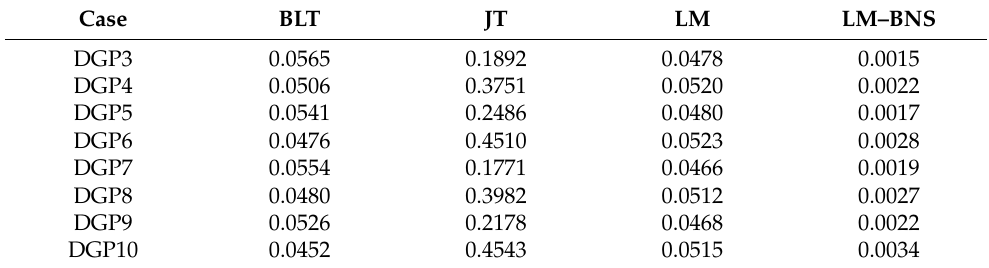
Table 4. Empirical sizes of co-jump tests under Monte Carlo simulations with idiosyncratic jumps